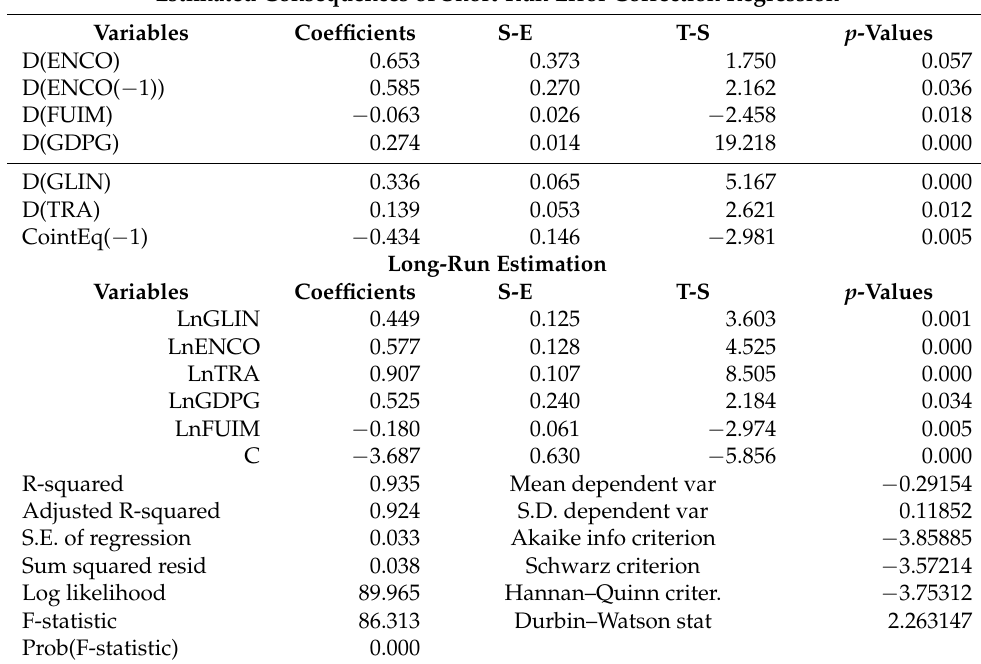
Table 5. Consequences of short- and long-run